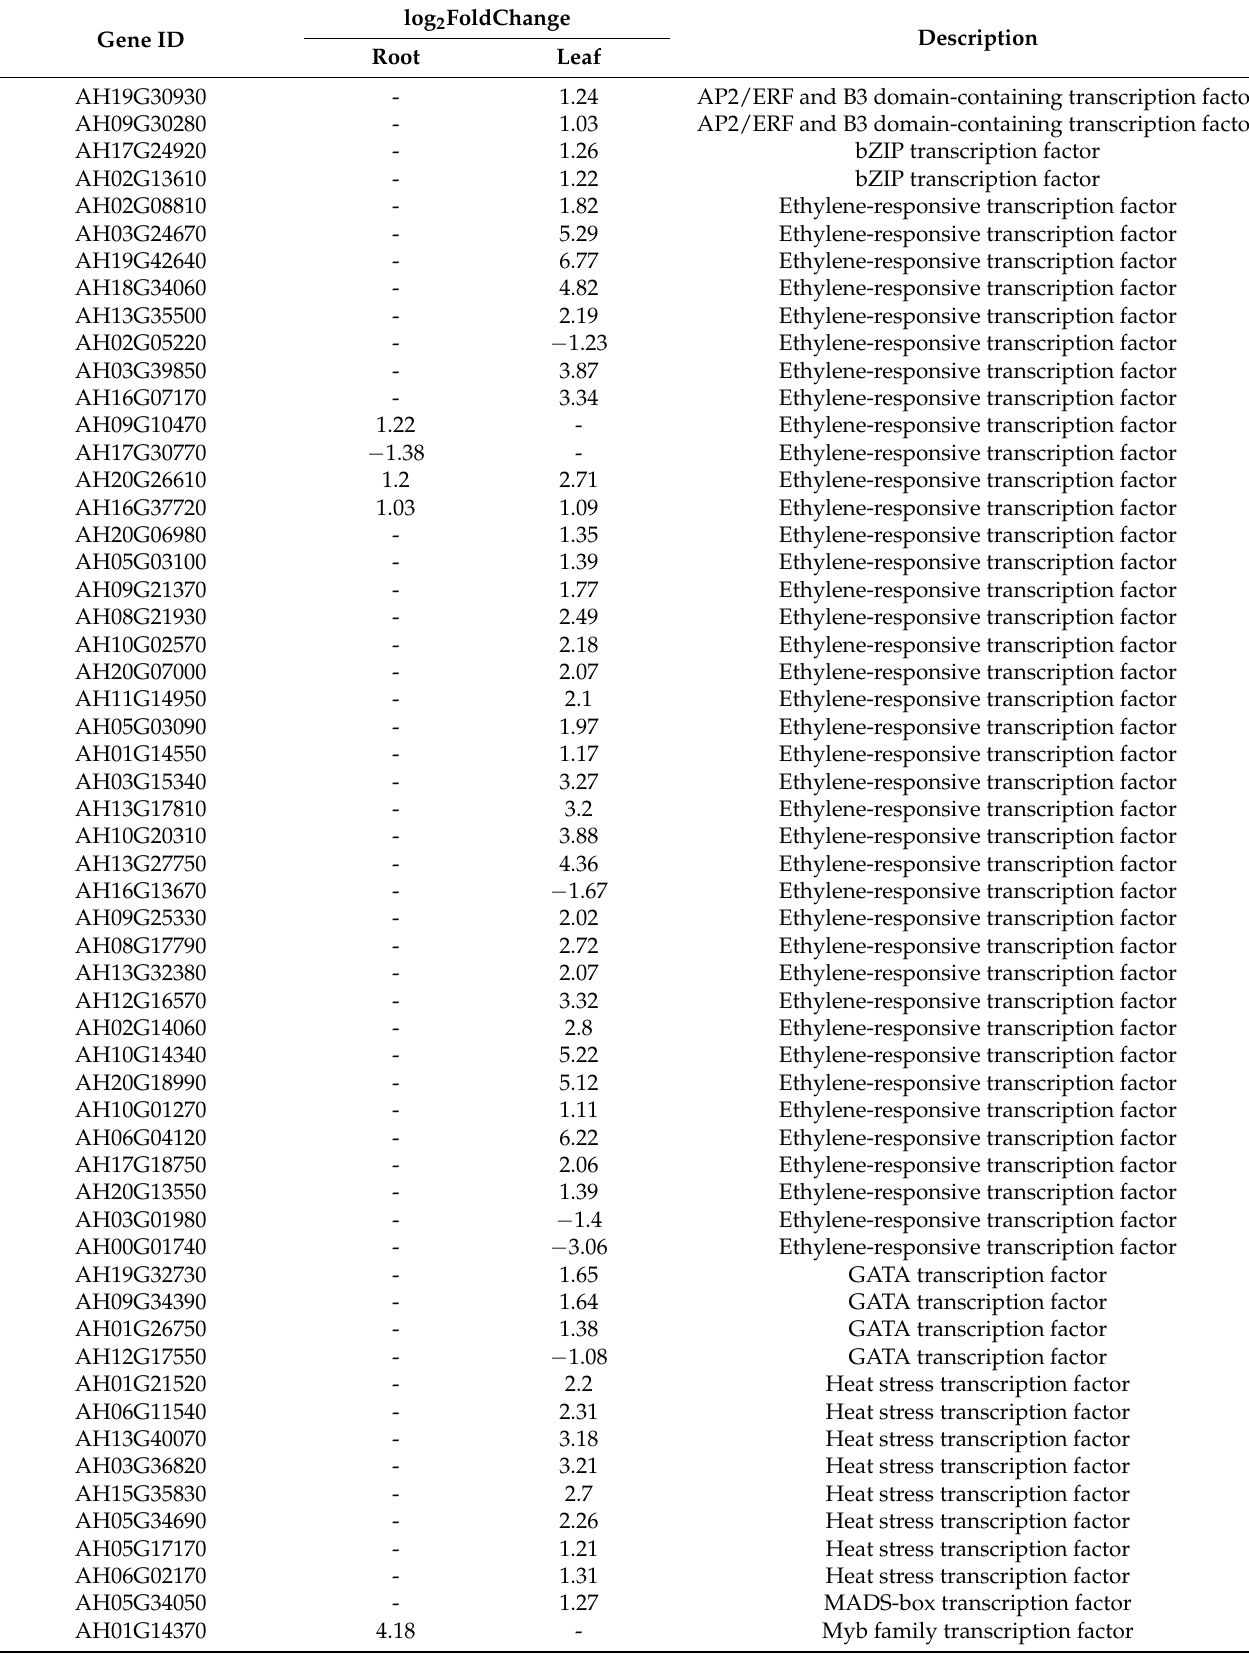
Table 7. Finding of DEGs that serve as transcription